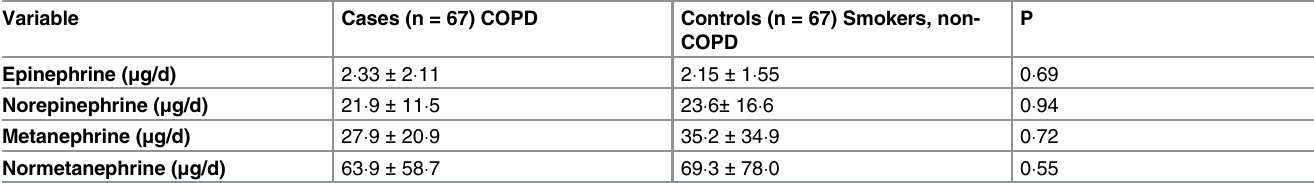
Table 3. Catecholamines and metabolites analysis results.